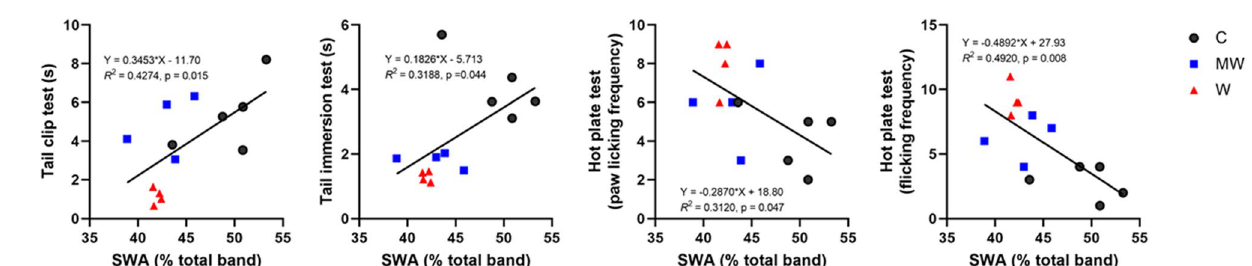
Figure 5. Correlation between sleep and pain on day 21 of PCMS. Scatter plot showing a positive correlation between slow-wave activity (SWA) during non-rapid eye movement sleep and reaction time to tail clip test, as well as between SWA and tail immersion test. Similarly, SWA shares a negative correlation between the hot plate test paw licking frequency and flicking frequency in the control (C), mesh wire (MW), and water (W) groups. SWA values used are the average values for 24 h. N = 4–5 per group; Pearson correlation